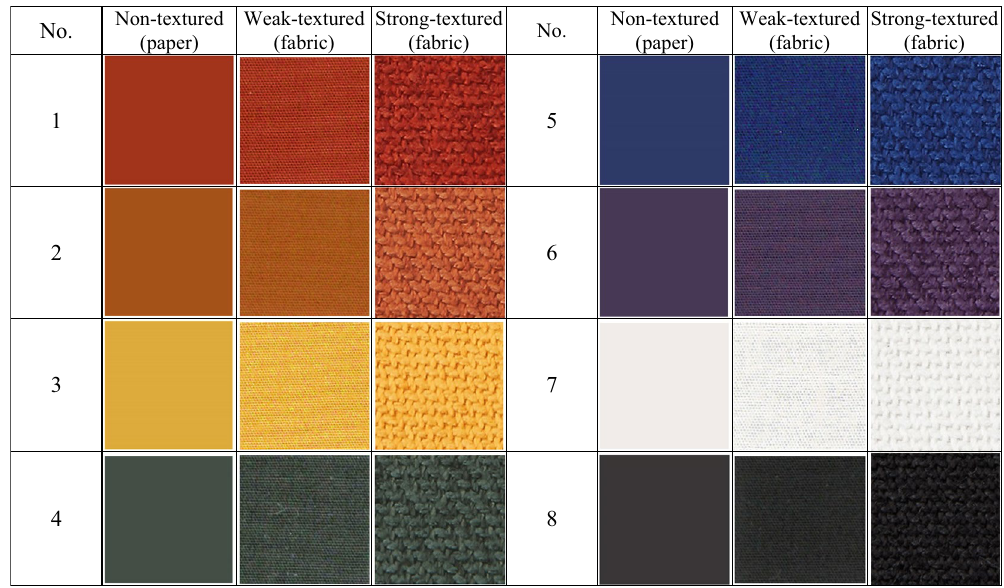
Table 2. Examples of samples with different texture strengths. Note that the scanned sample images might not faithfully represent the real colors measured in the experiment due to the different media on which the colors are represented.